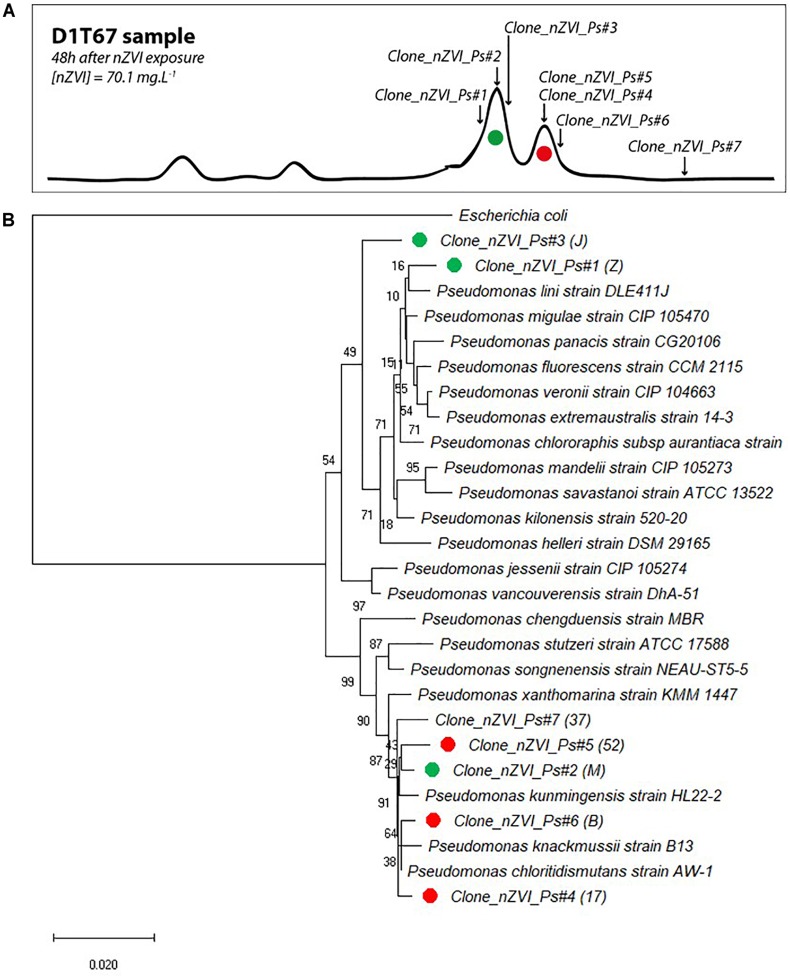
(A) Correspondence of sequenced clones in bacterial community fingerprints (here presented data from condition D 1 at T67). Green clones correspond to the first peak of interest and red clones to the second peak of interest (peak that appeared in the presence of nZVI). (B) Evolutionary relationships of taxa. The percentage of replicate trees in which the associated taxa clustered together in the bootstrap test (1000 replicates) are shown next to the branches. The tree is drawn to scale, with branch lengths in the same units as those of the evolutionary distances used to infer the phylogenetic tree.